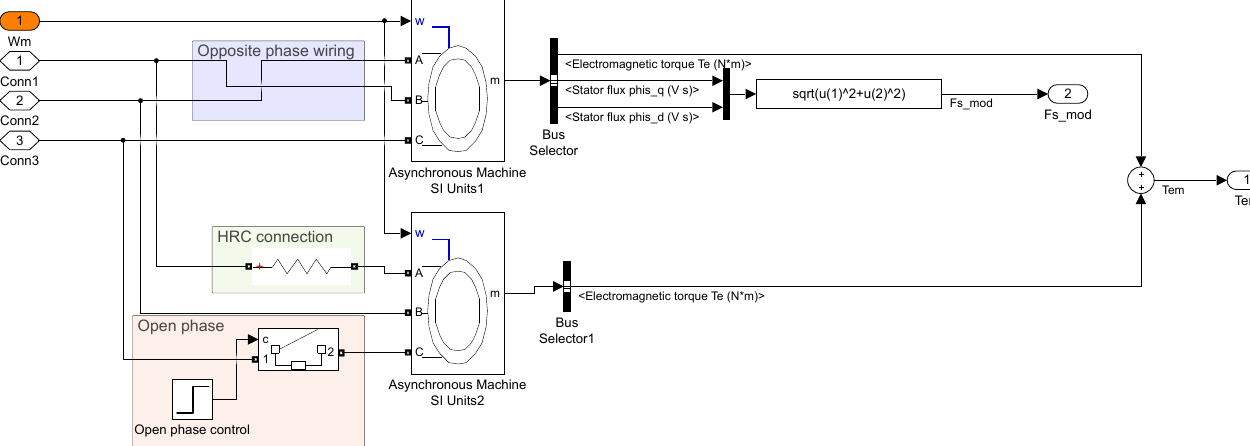
Figure 5. IM power connection faults modelled in the SiL